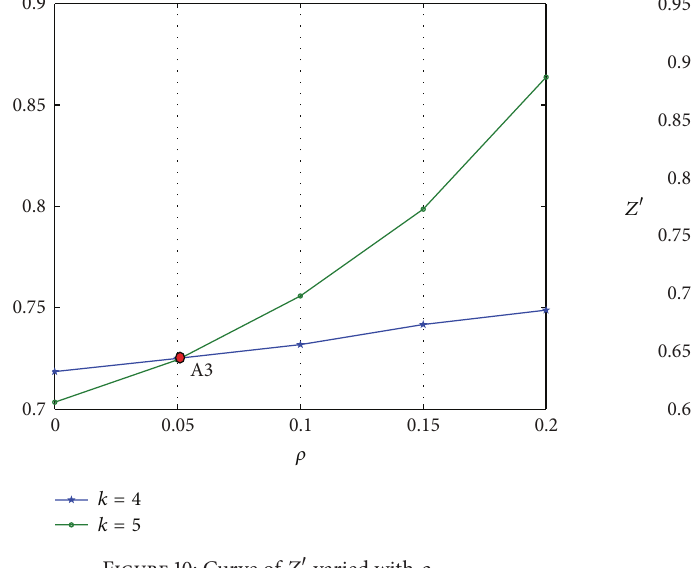
Figure 12: 𝑍 󸀠 varied with 𝜌 (𝑅 = 3) .